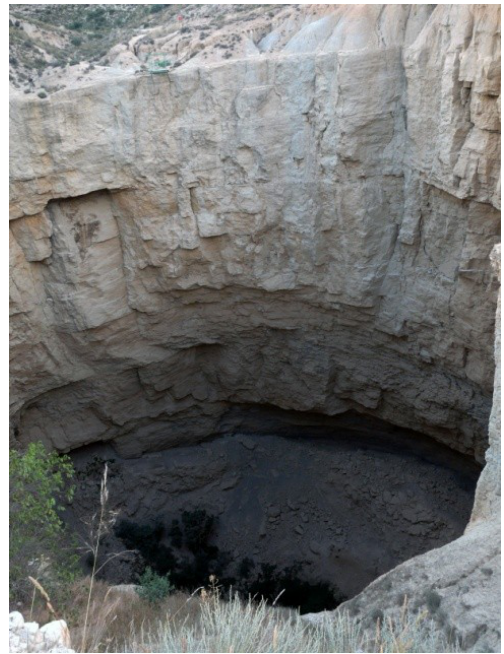
Figure 1. San Pedro de los Griegos